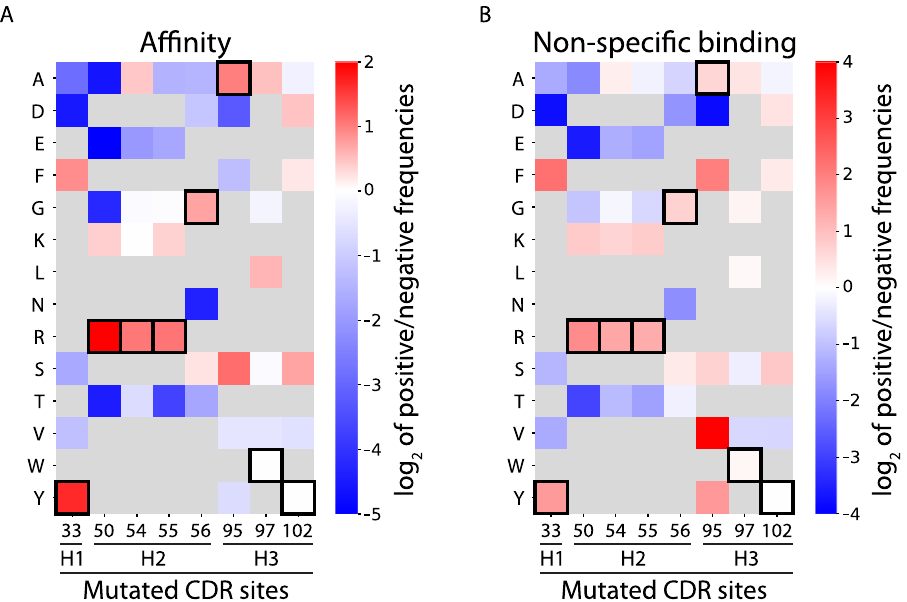
Fig. 2 Levels of CDR residue enrichment in the sorted emibetuzumab libraries are similar for high af fi nity and high non-speci fi c binding selections. Calculated ratios between the amino acid frequencies at each mutated site for library samples selected for ( A ) high af fi nity relative to low af fi nity and ( B ) high non-speci fi c binding (ovalbumin and soluble membrane proteins) relative to low non-speci fi c binding. Red mutations appeared more frequently in the high af fi nity and high non-speci fi c binding library samples, while blue mutations appeared more frequently in the low af fi nity and low non-speci fi c binding library samples. Wild-type residues are highlighted with black boxes, and residues that were not sampled in the libraries are indicated with gray